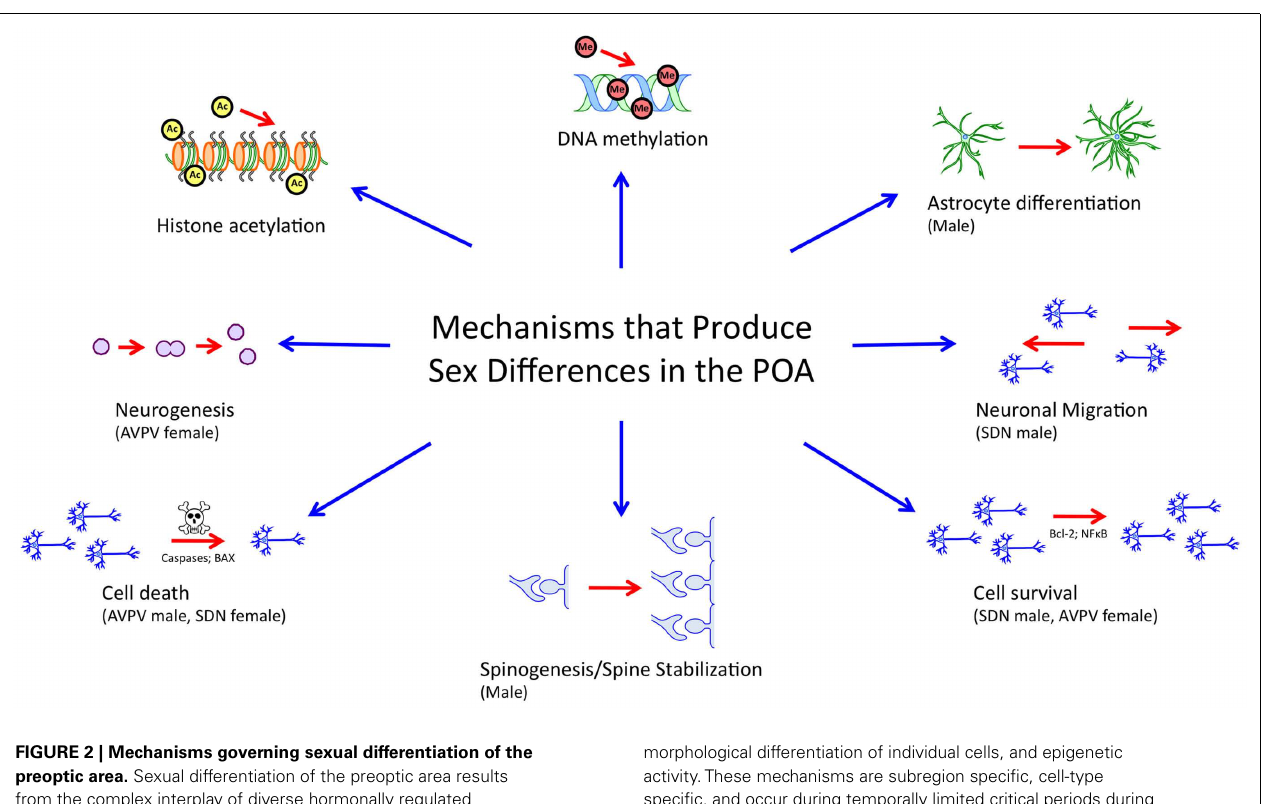
FIGURE 2 | Mechanisms governing sexual differentiation of the preoptic area. Sexual differentiation of the preoptic area results from the complex interplay of diverse hormonally regulated mechanisms, including neurogenesis, cell survival and death,